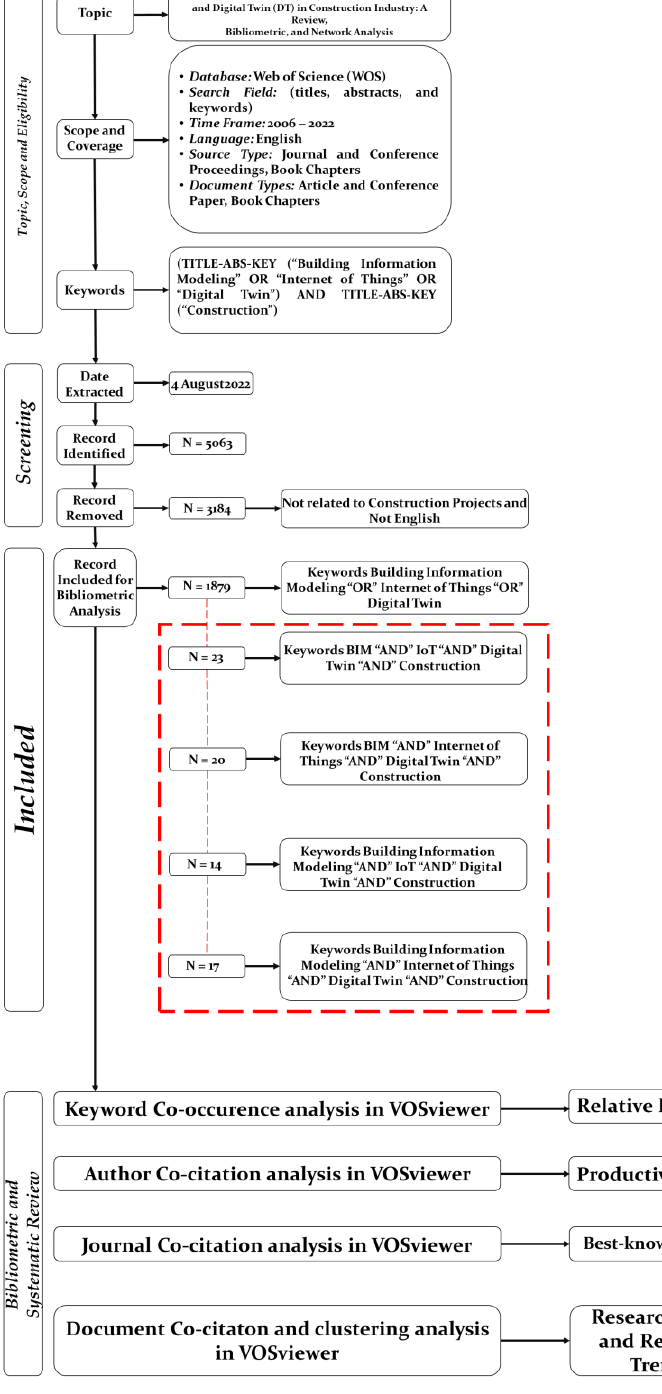
Figure 3. The methodological framework of the current